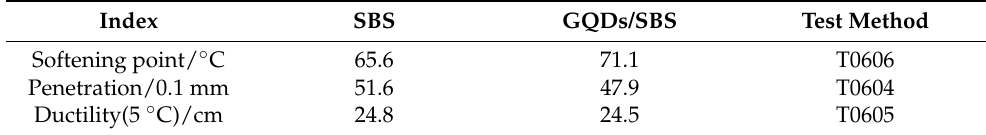
Table 3. Physical property of SBS-modified asphalt and GQDs/SBS composite-modified asphalt.